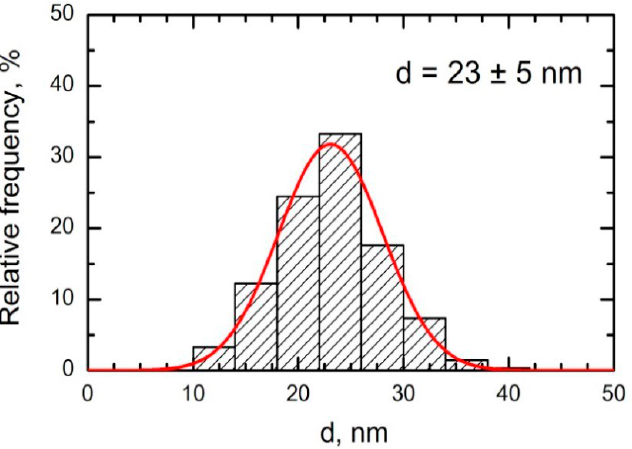
Figure 2. Particle size distribution function obtained by statistical processing SEM images of parti- cles accumulated on a polycarbonate filter from the exposed rats’ breathing zone in the experiment with NiO-NP in the concentration 230 ± 10 µg/m 3 [22].